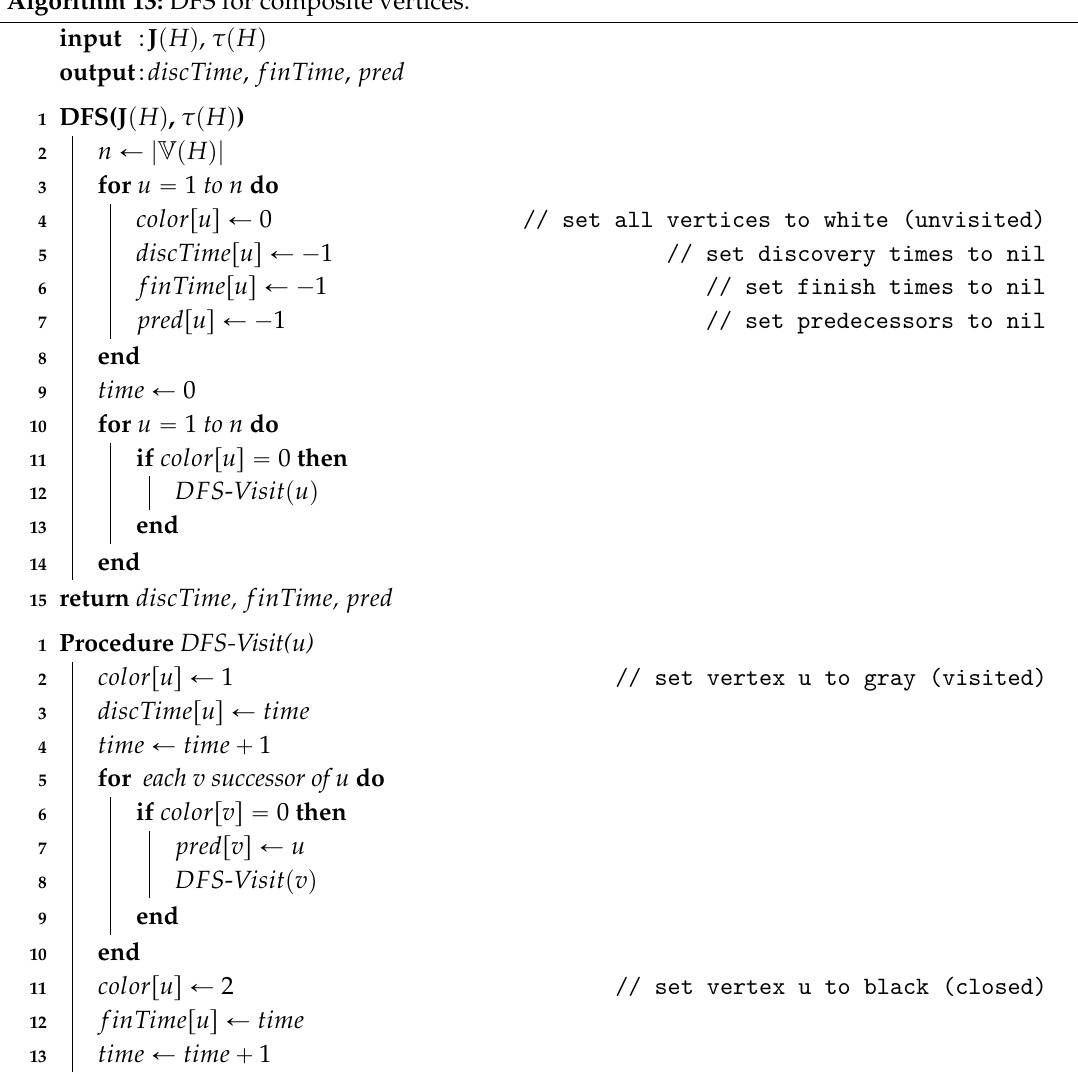
Algorithm 13: DFS for composite